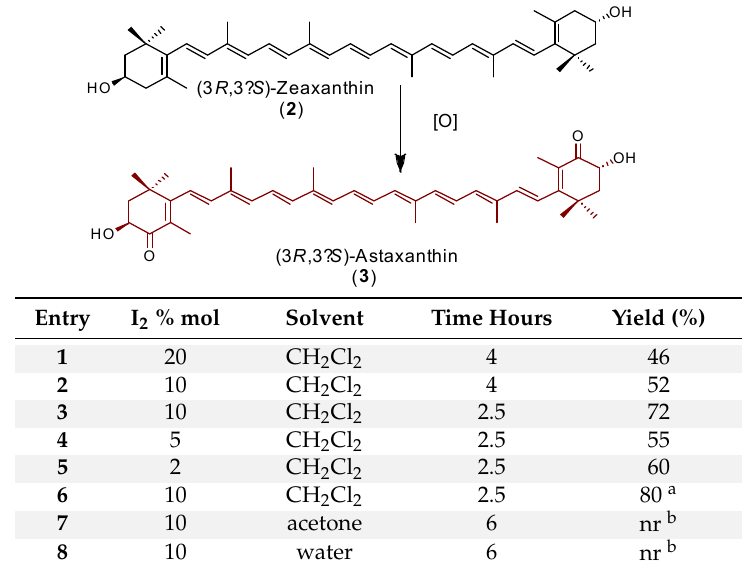
Table 4. Oxidation reaction of (3 R ,3’ S )-zeaxanthin to (3 R ,3’ S )-astaxanthin.